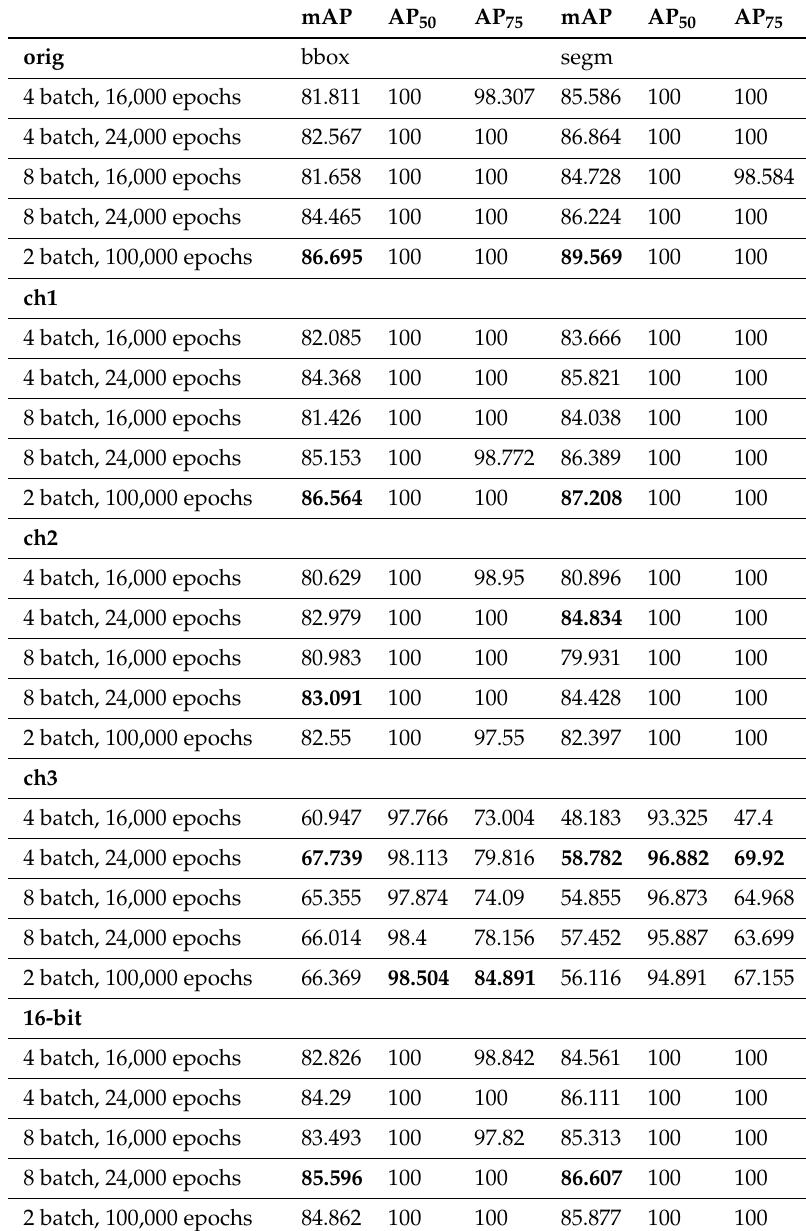
Table 3. Training results for Mask R-CNN from scratch learning and 500 images.